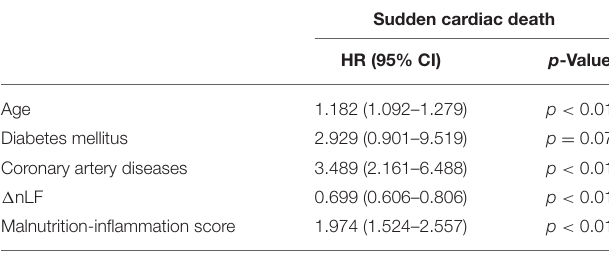
TABLE 4 | Univariate Cox regression analysis of key prognostic factors for sudden cardiac death.